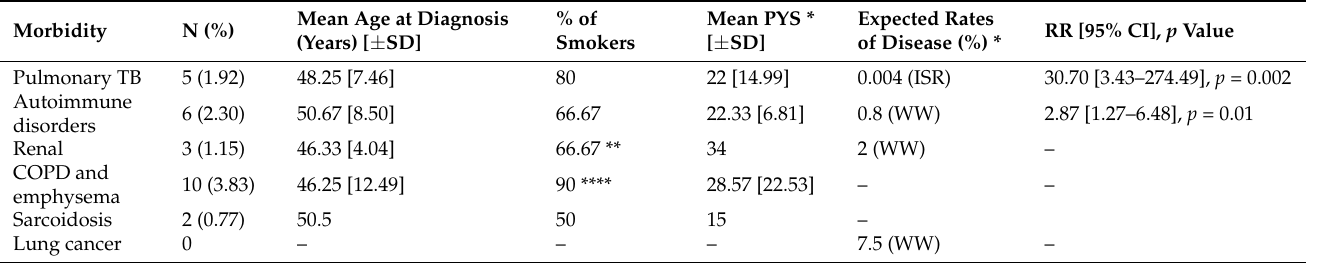
Table 4. Associations between silica exposure and rate of various diseases of interest compared to the general population.